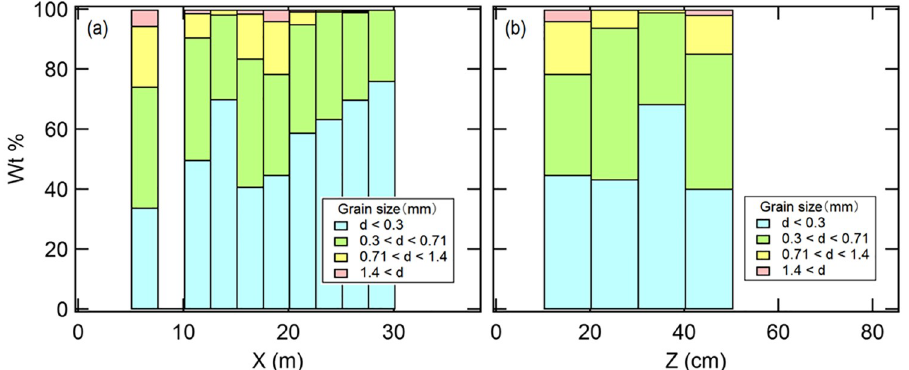
Fig 4. Grain size distribution of beach sand collected at the Tsu site. Panels: (a) The horizontal axis is distance from shoreline ( X ), and (b) is substrate depth ( Z ). Beach sand samples were sifted into four diameter particle sizes: d < 0.3 mm (turquoise bars), 0.3 < d < 0.71 mm (green bars), 0.71 < d < 1.4 mm (yellow bars), and 1.4 mm < d (pink bars). Wt = percent